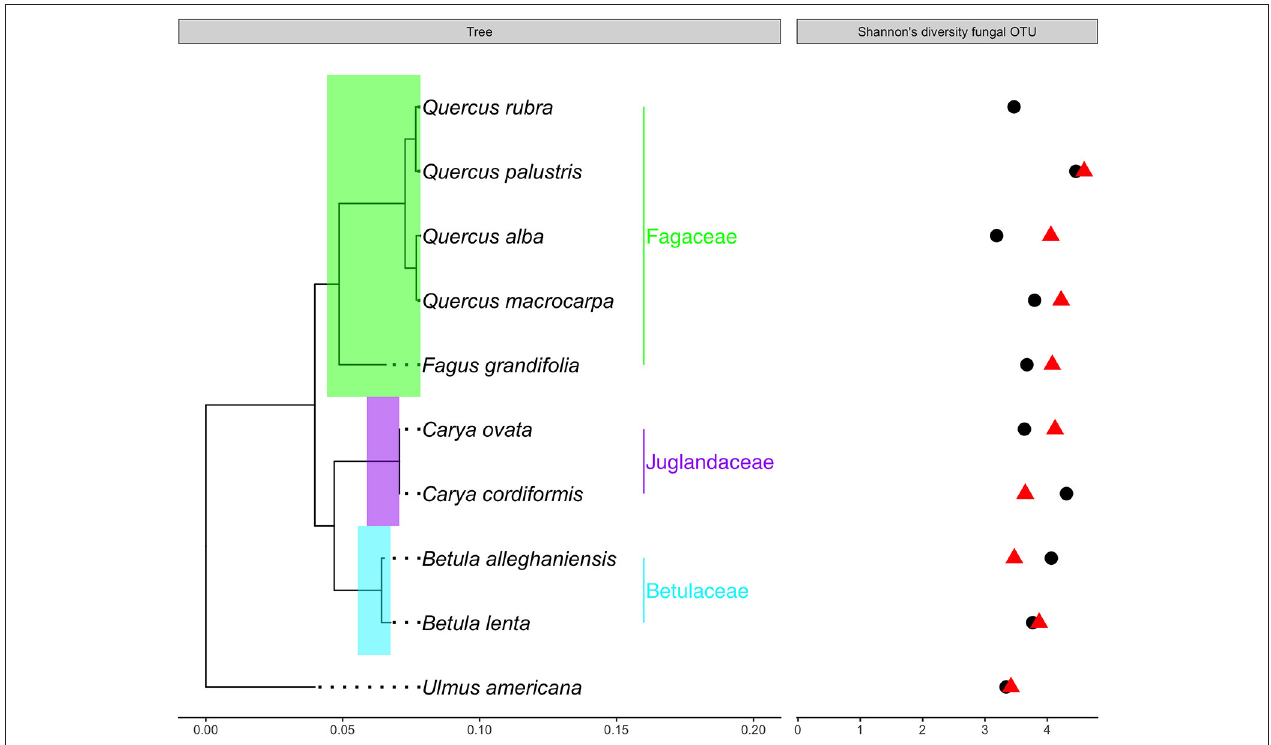
FIGURE 1 | A maximum likelihood phylogeny for 10 tree species, which associate with ectomycorrhizal fungi. Two DNA regions, mat K and rbc L were used to estimate this phylogeny ( Supplementary Material S2 ). Branch lengths are in substitutions per site. Shannon’s diversity of fungal communities following inoculation with conspecific soil (black dots) or heterospecific soils (red triangles) are represented to the right of the